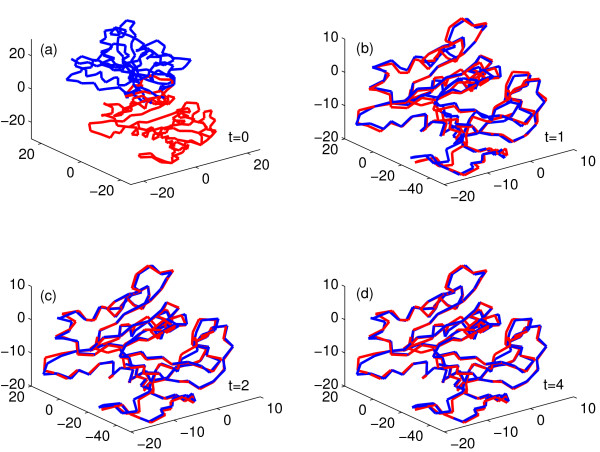
An example of the alignment for two protein chains 1DHFa and 8DFR. The iteration number of the algorithm is represented by t. (a) The two proteins 1DHFa and 8DFR are in the original coordinates, which are in the Cα representation of the backbone. (b) and (c) Relative positions of the two proteins during the convergence process. (d) The optimal alignment by our algorithm. The final alignment number m is 182 with rms = 0.7 at λ = 6.0 and λ¯
 MathType@MTEF@5@5@+=feaafiart1ev1aaatCvAUfKttLearuWrP9MDH5MBPbIqV92AaeXatLxBI9gBaebbnrfifHhDYfgasaacH8akY=wiFfYdH8Gipec8Eeeu0xXdbba9frFj0=OqFfea0dXdd9vqai=hGuQ8kuc9pgc9s8qqaq=dirpe0xb9q8qiLsFr0=vr0=vr0dc8meaabaqaciaacaGaaeqabaqabeGadaaakeaaiiGacuWF7oaBgaqeaaaa@2E7F@ = 0.0.